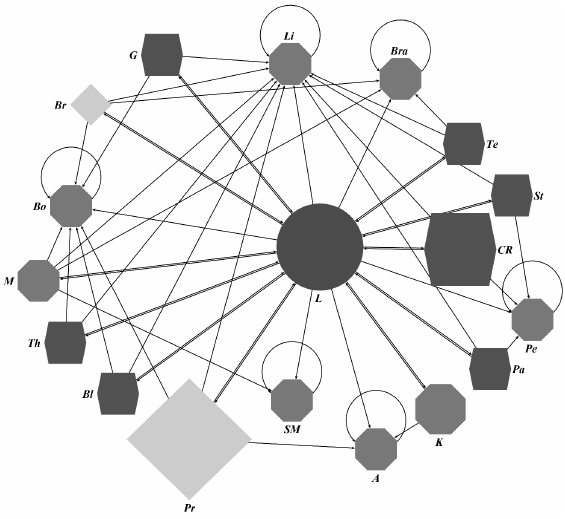
Fig. 1: Graph for the principal links of metastasis for tumors in males based in statistics. The name of the organs were referred by a symbol as de- picted in Table